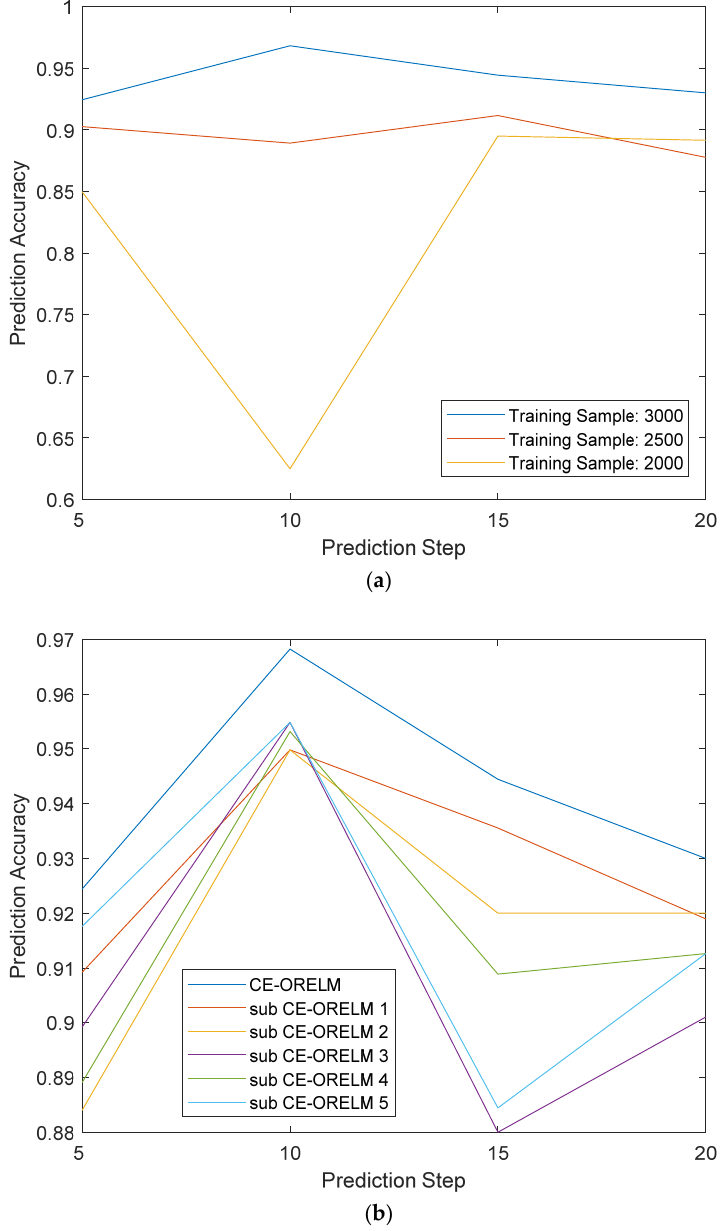
Figure 8 . Prediction accuracies ( a ) under different samples ( b ) under different sub CE-ORELM. Figure 8. Prediction accuracies ( a ) under di ff erent samples ( b ) under di ff erent sub CE-ORELM. Table 2. Weights of sub-online recurrent extreme learning machine